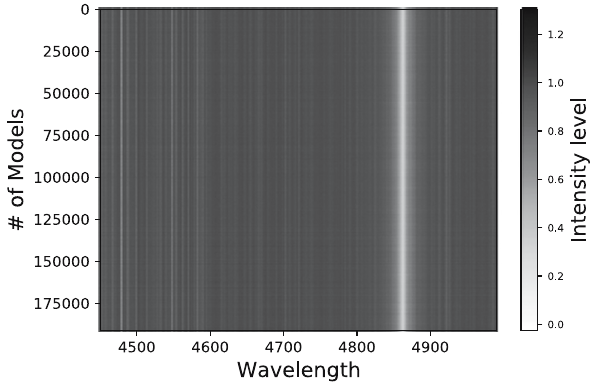
Figure 1: Colour map representing the fl uxes for a sample of the training database using data augmentation. Wavelengths are in Å .